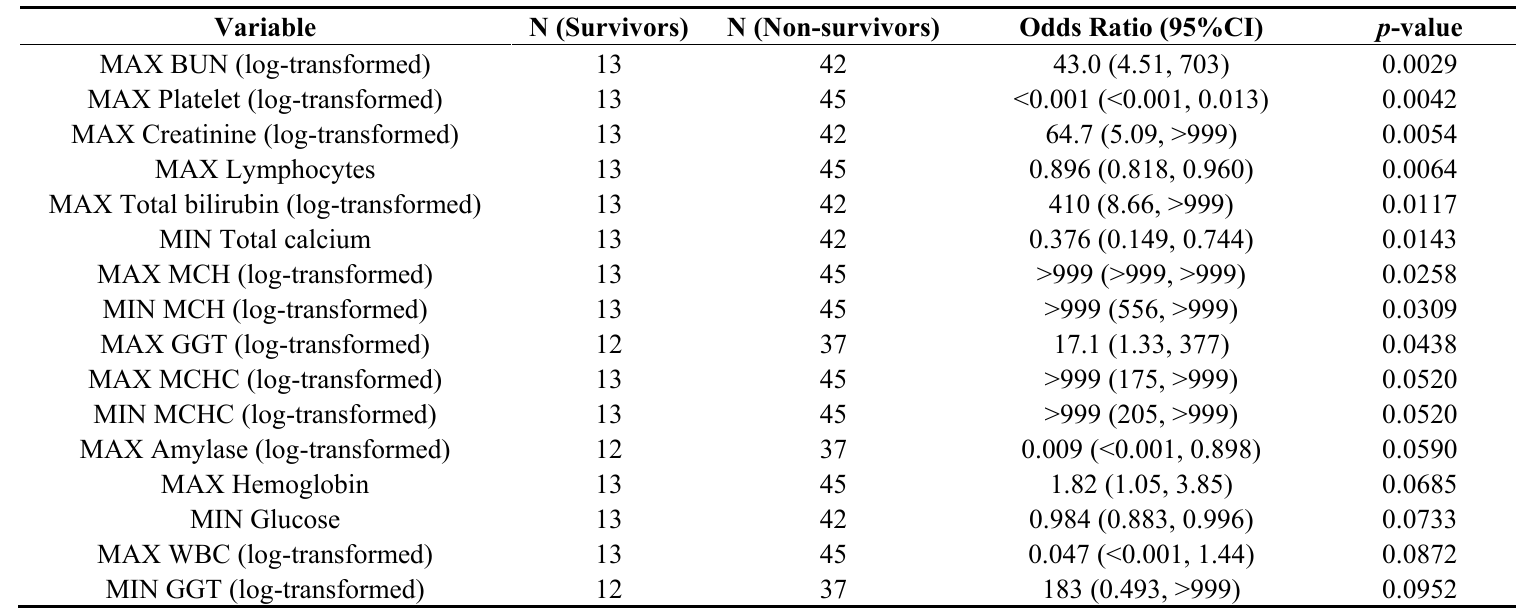
Table 3. Results of logistic regression analysis of maximal or minimal clinical pathology parameters (assessed over the course of Ebola virus infection) and survival outcome in 58 rhesus monkeys. Data were compiled from multiple independent experiments. Parameters exhibiting a significant relatedness to survival outcome ( p -value < 0.10) are